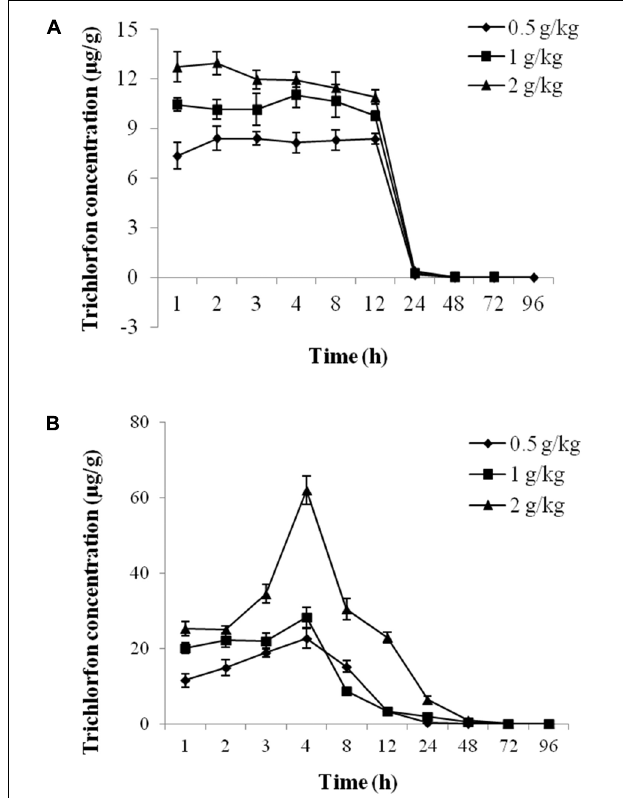
FIGURE 1 | The concentration-time profile of trichlorfon in Carassius auratus gibelio plasma and liver tissue after oral exposure. (A) Plasma; (B) liver ( n = 3, data are shown as the mean ±